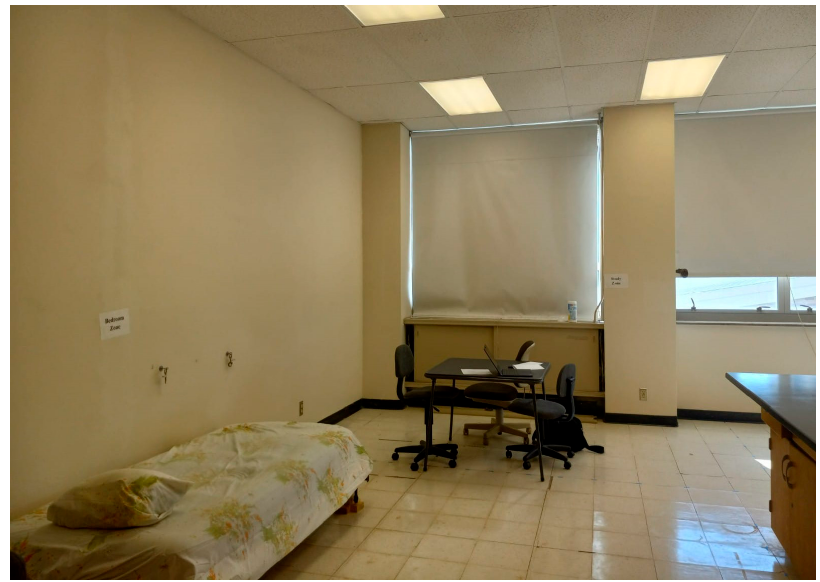
Figure 8. Overview of the lab space showing two ‘activity-based zones’ (bedroom zone and study zone) with multiple contextual parameters.